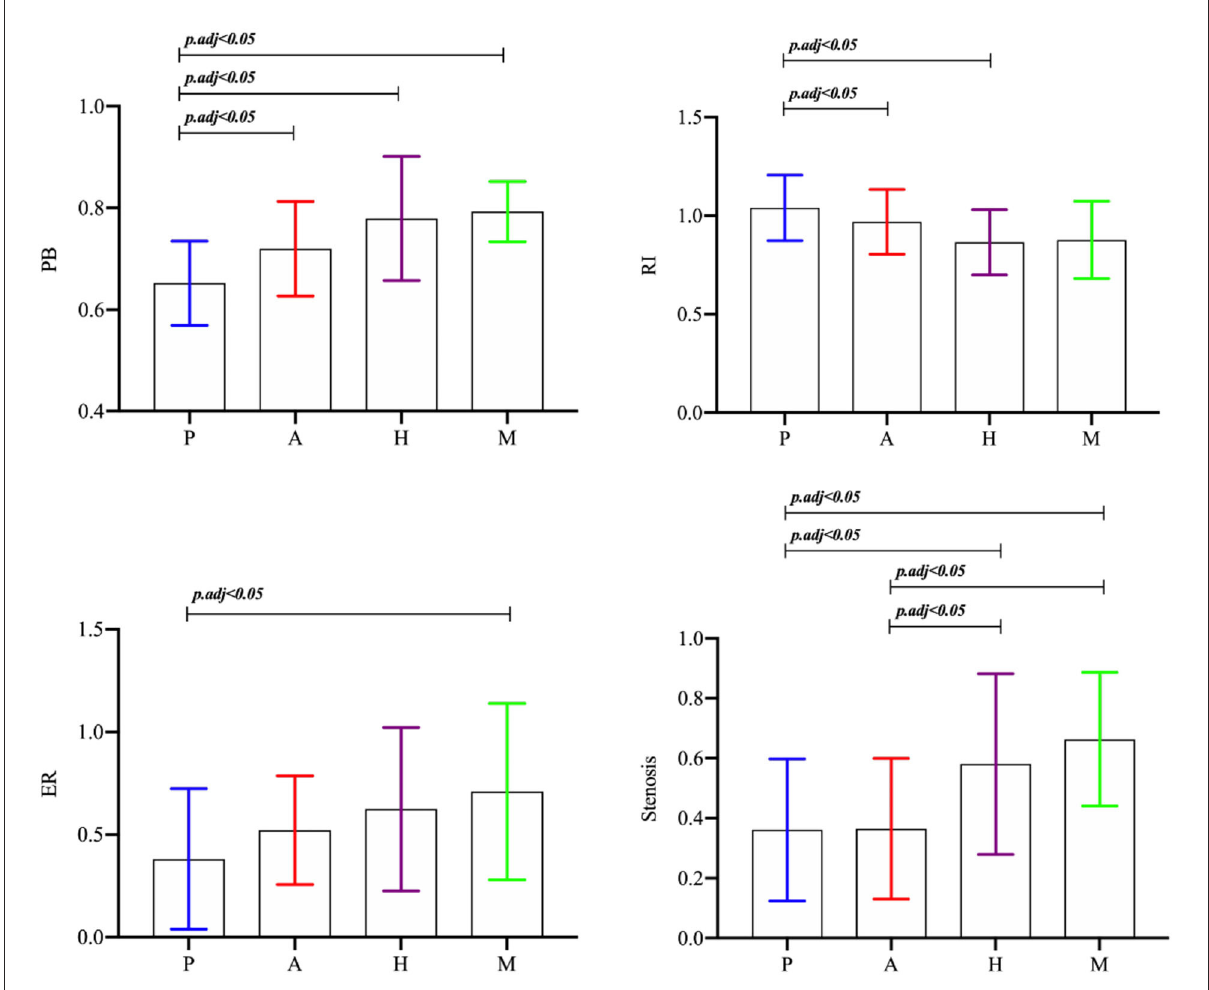
FIGURE3 The p- values were calculated using